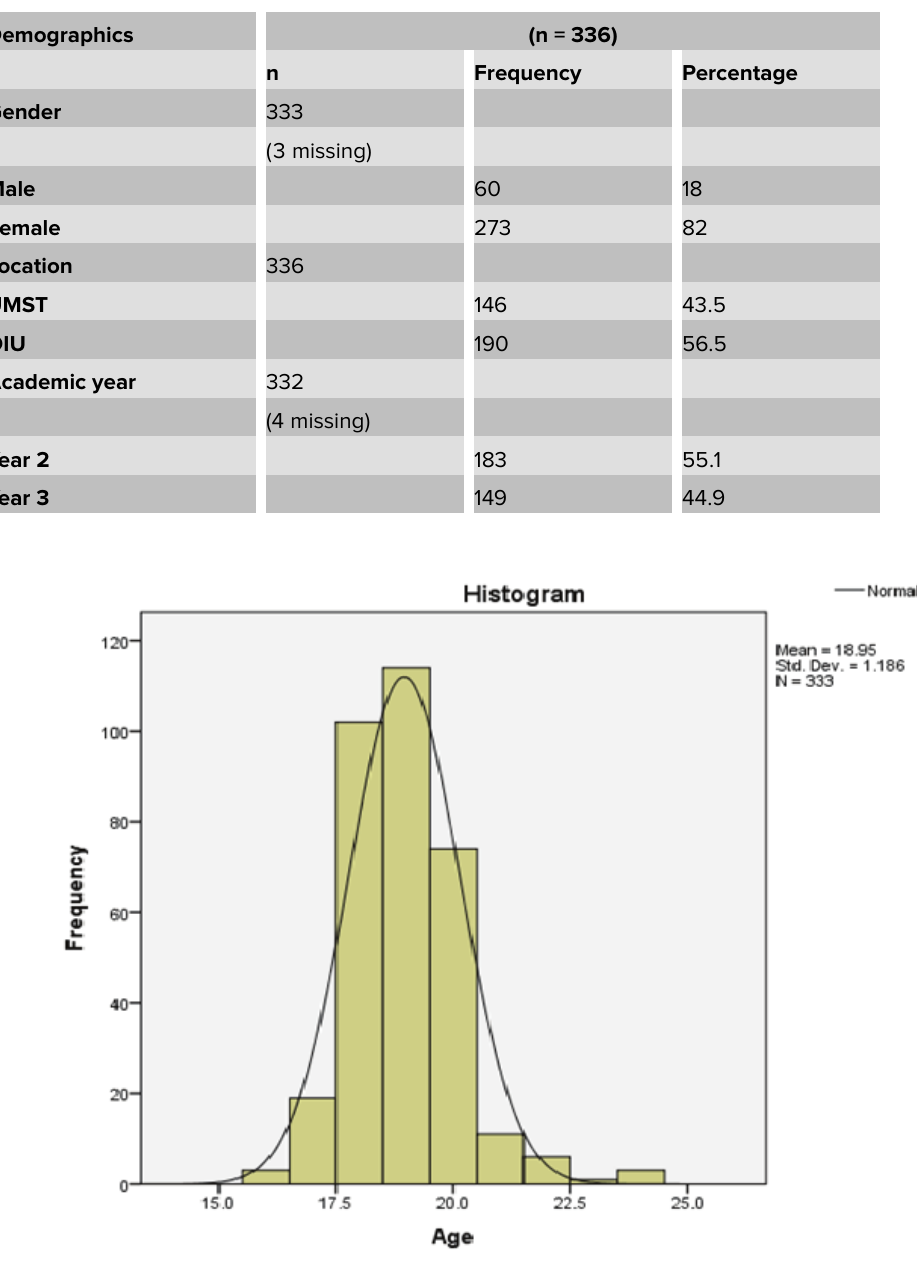
Table 1: The demographic characteristics of the study participants.